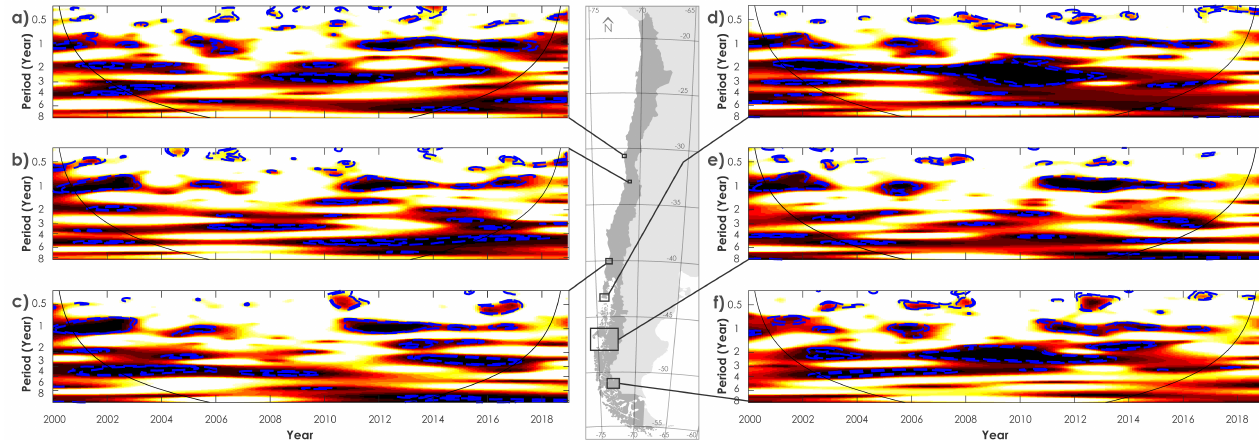
Figure 5. Wavelet coherence between the EVI and PDO temporal signal in national parks. ( a ) Fray Jorge, ( b ) La Campana, ( c ) Alerce Costero, ( d ) Tantauco, ( e ) San Rafael and ( f ) Torres del Paine. The colors are coded from yellow (low coherence) to dark red (high coherence). The dotted-dashed blue lines show the 95% and the 90% significance levels computed based on bootstrapped series. The cone of influence (black line) indicates the region not influenced by edge effects (see [56]).